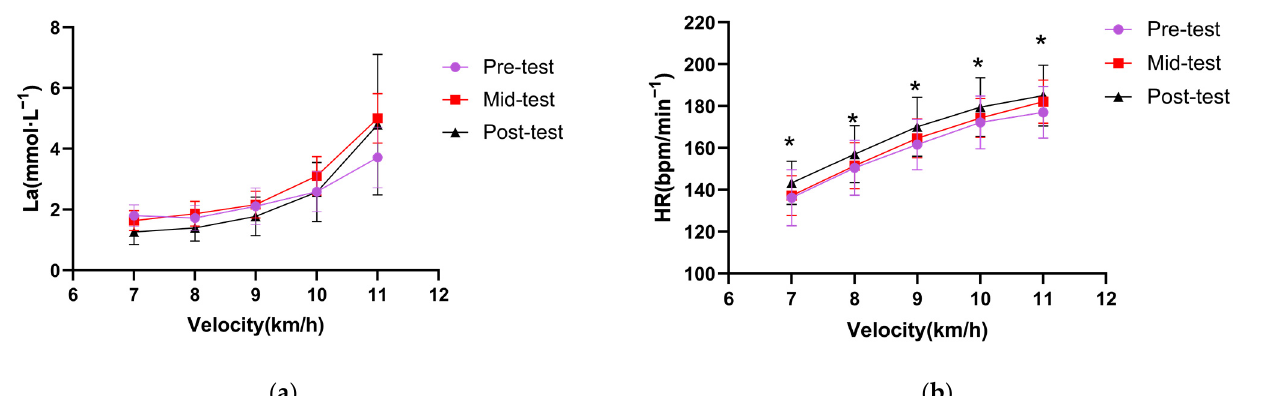
Figure 3. Eight elite Chinese cross-country skiers’ lactate-velocity curve ( a ) and heart rate-curve ( b ) from lactate threshold test . * indicates a significant difference compared to pre-test (* p < 0.05). Abbreviations: La = lactate, HR = heart rate.